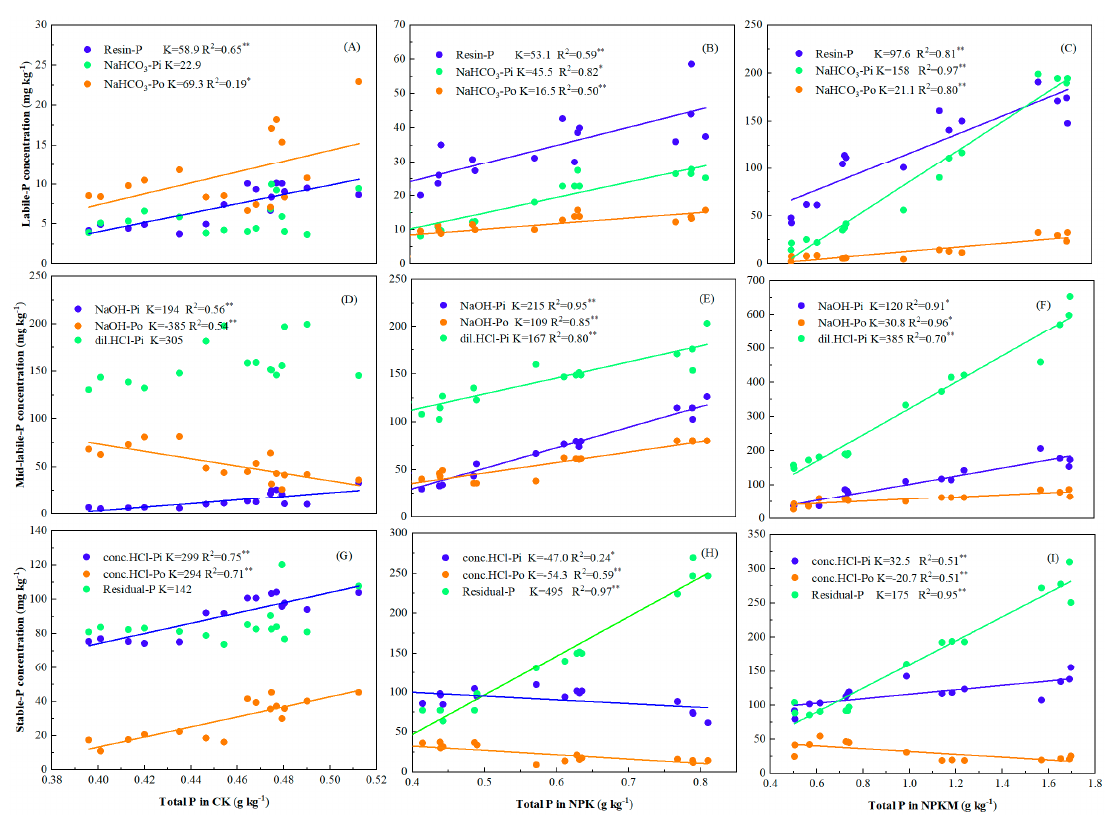
Figure A1. The correlation between total P and each P fraction in CK ( A , D , G ), NPK ( B , E , H ) and NPKM ( C , F , I ) treatments under long-term experiment. Fitted curves were: y = Kx + b. CK, no fertilizer input; NPK treatment, applying N, P, K fertilizer; NPKM treatment, applying NPK and manure (pig manure from 1990 to 2004, and cattle manure from 2005 to 2018). Total P, the sum content of each P fraction extracted by the Hedley sequential method. * and ** mean the relationship between total P and P fraction in p < 0.05, p < 0.01 level, respectively.